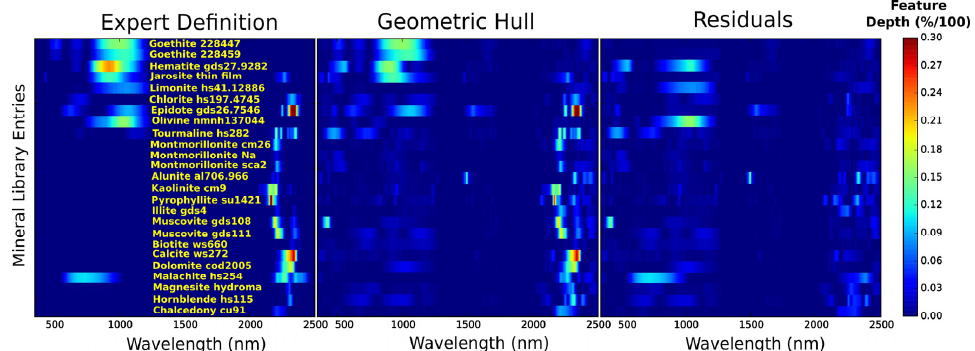
Figure 6. Characteristic absorption features of minerals in the solar reflective region extracted manually by expert knowledge based feature definition ( left ) and by the fully automated geometric hull technique ( middle ). Spectral entries belong to the USGS spectral library [12]. The residuals between the geometric hull feature definition and the expert definition are shown in the right image.